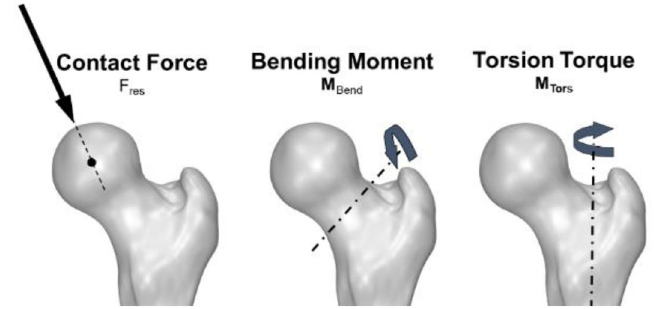
Figure 1. In vivo determined joint loads; resultant joint contact force (F res ) in the hip joint, the bending moment at the femur neck (M Bend ) and the torsion torque around the femur stem (M Tors ).